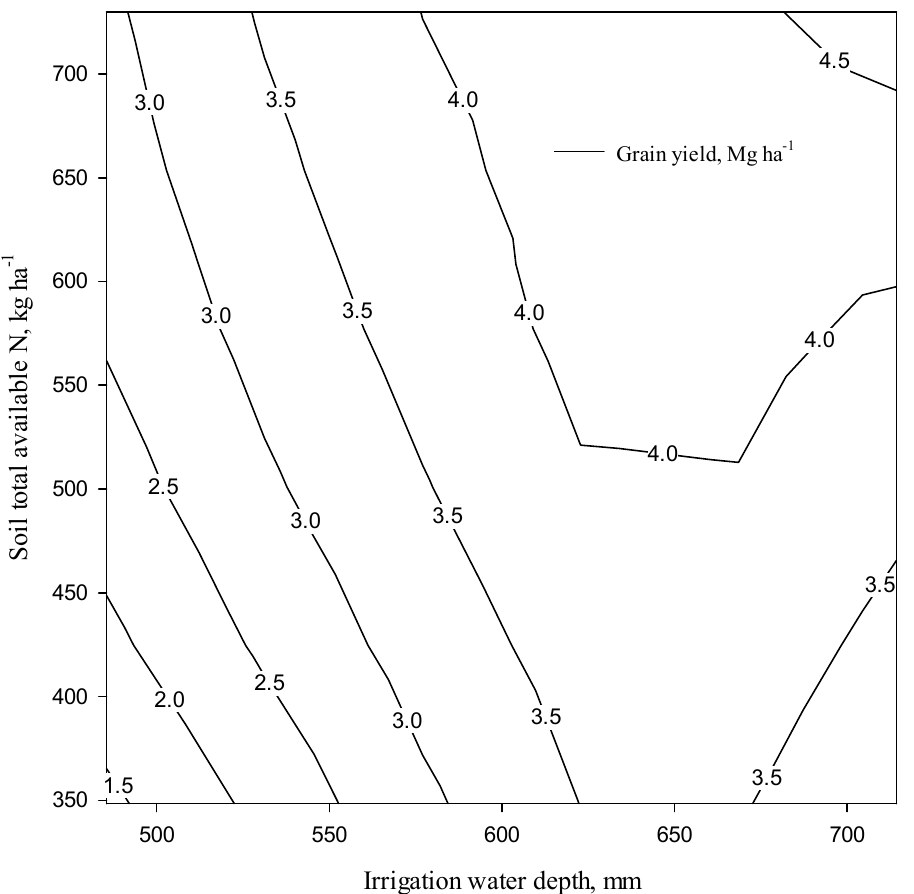
Figure 5. Nomo graph showing the relationship between irrigation water depth and soil total available N for obtaining different quinoa seed yields.